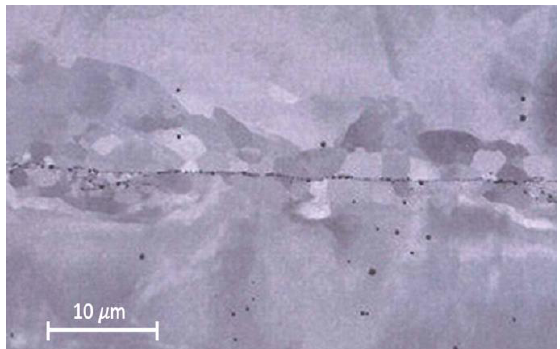
Figure 7. Scanning electron microscopy (SEM) image in backscattered electron (BSE) imaging of the interface between two joined disks with ground surfaces.